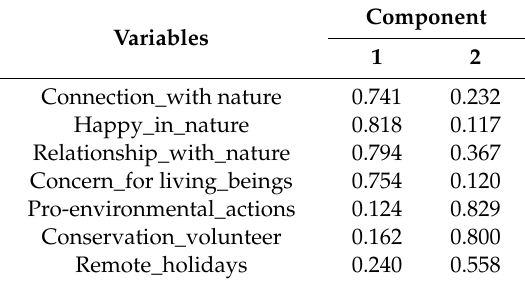
Table 8. Rotated component